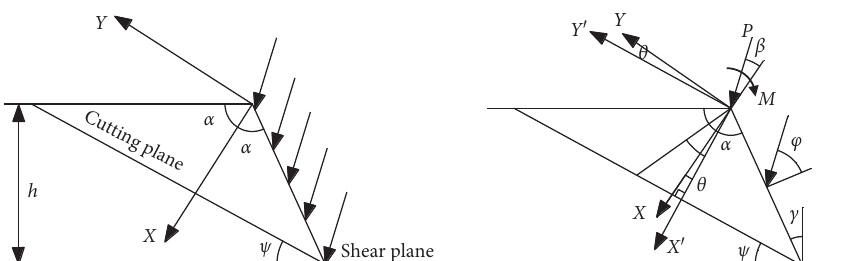
Figure 1: Shear stress analysis of drill bit